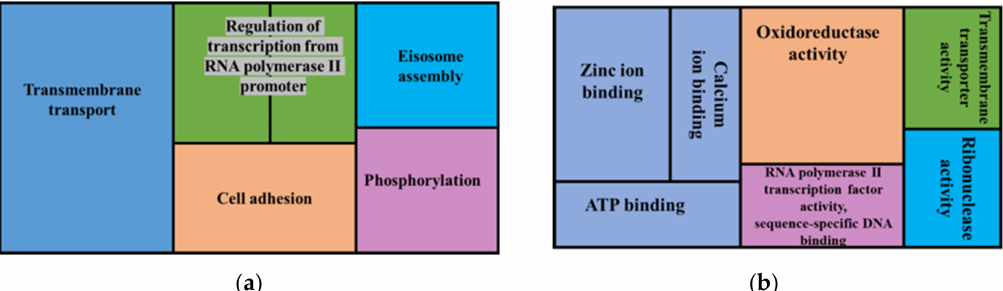
Figure 8. GO enrichment analysis of genes predicted to have high impact variants showing over- represented GO terms, biological processes ( a ) and molecular functions ( b ). The whole genome annotations of the reference FSP34 were used as the reference set and genes predicted to have high impact variants were used as the test set.